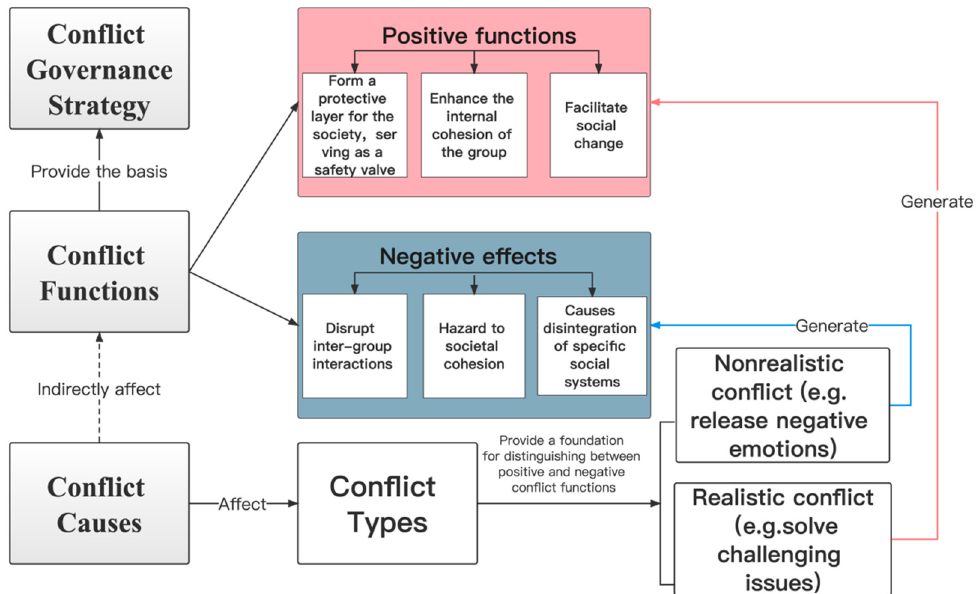
Figure 1. A framework based on FCT. Source: Authors.